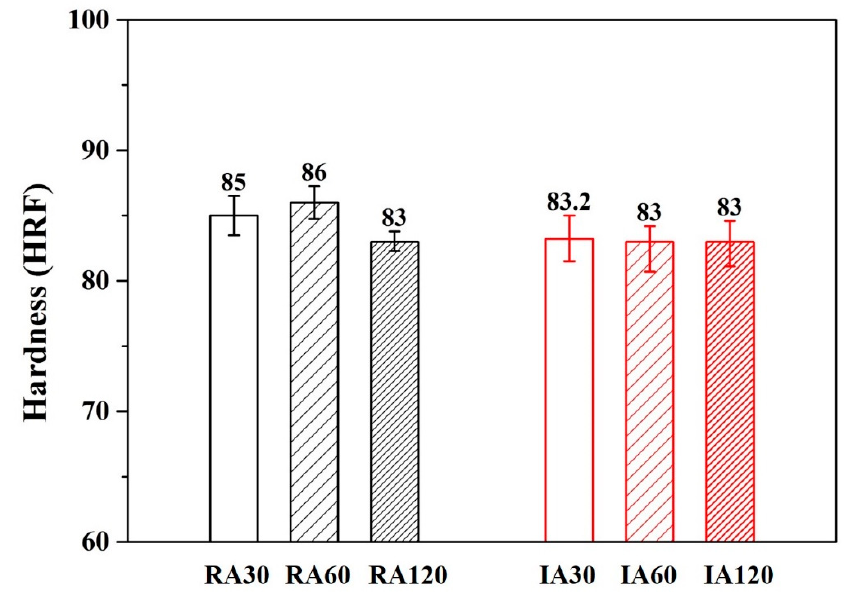
Figure 7. Hardness of various heat-treated forging A specimens.